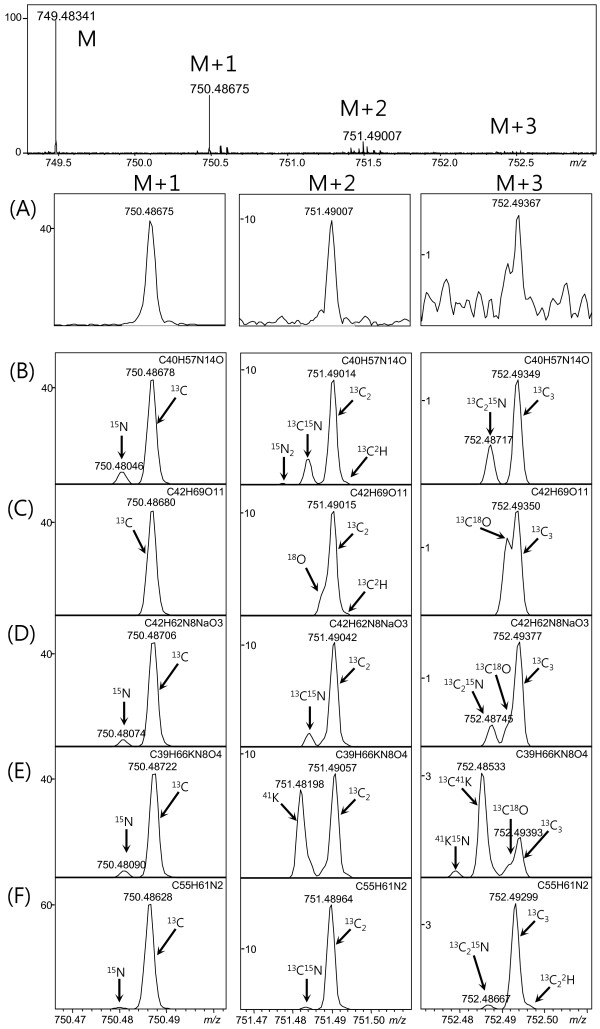
Comparison of the experimental and the theoretical IFSs. The experimental IFS of the ions with monoisotopic peaks at m/z 749.48341 (A) and five theoretical IFSs for [C40H57N14O]+ (B), [C42H69O11]+ (C), [C42H62N8O3Na]+ (D), [C39H66N8O4K]+ (E), and [C55H61N2]+ (F). From the comparison between the experimental IFS and the theoretical IFSs, the ionic formula of the compound at m/z 749.48341 was assigned to [C42H69O11]+, the molecular formula of (C). Calculated peak intensity of the each isotopic peak in the isotopic fine structures of candidate molecular ions is listed in Additional file
1.